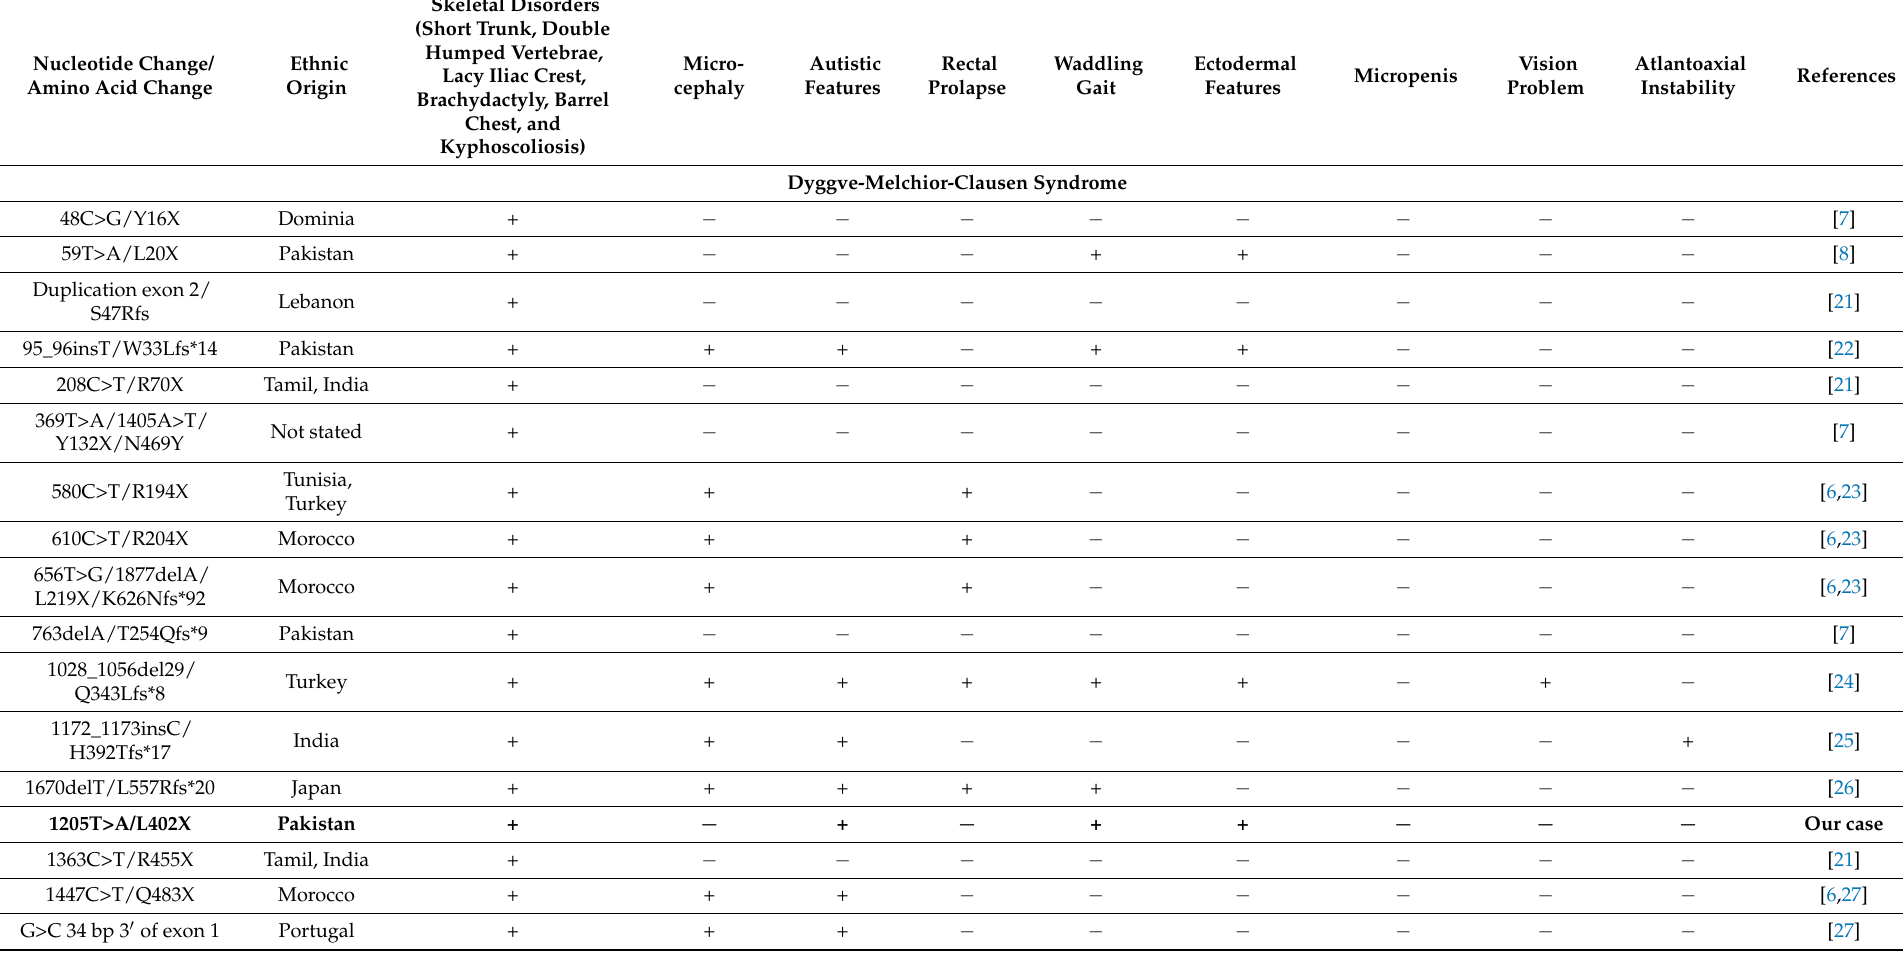
Table 1. DYM mutations causing DMC and SMC in different ethnic groups with correlation of clinical phenotypes of our family and previously reported